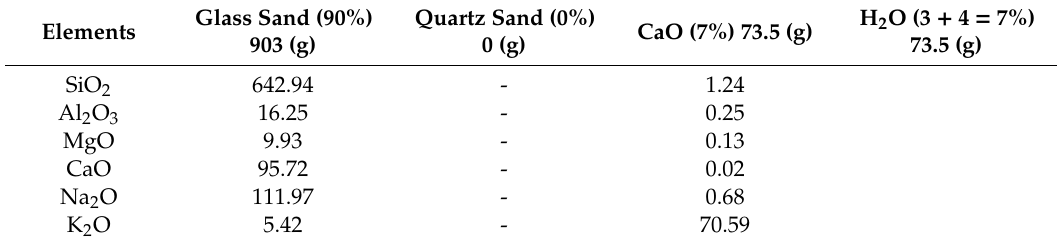
Table 5. Quantities of individual components used to manufacture bricks containing glass